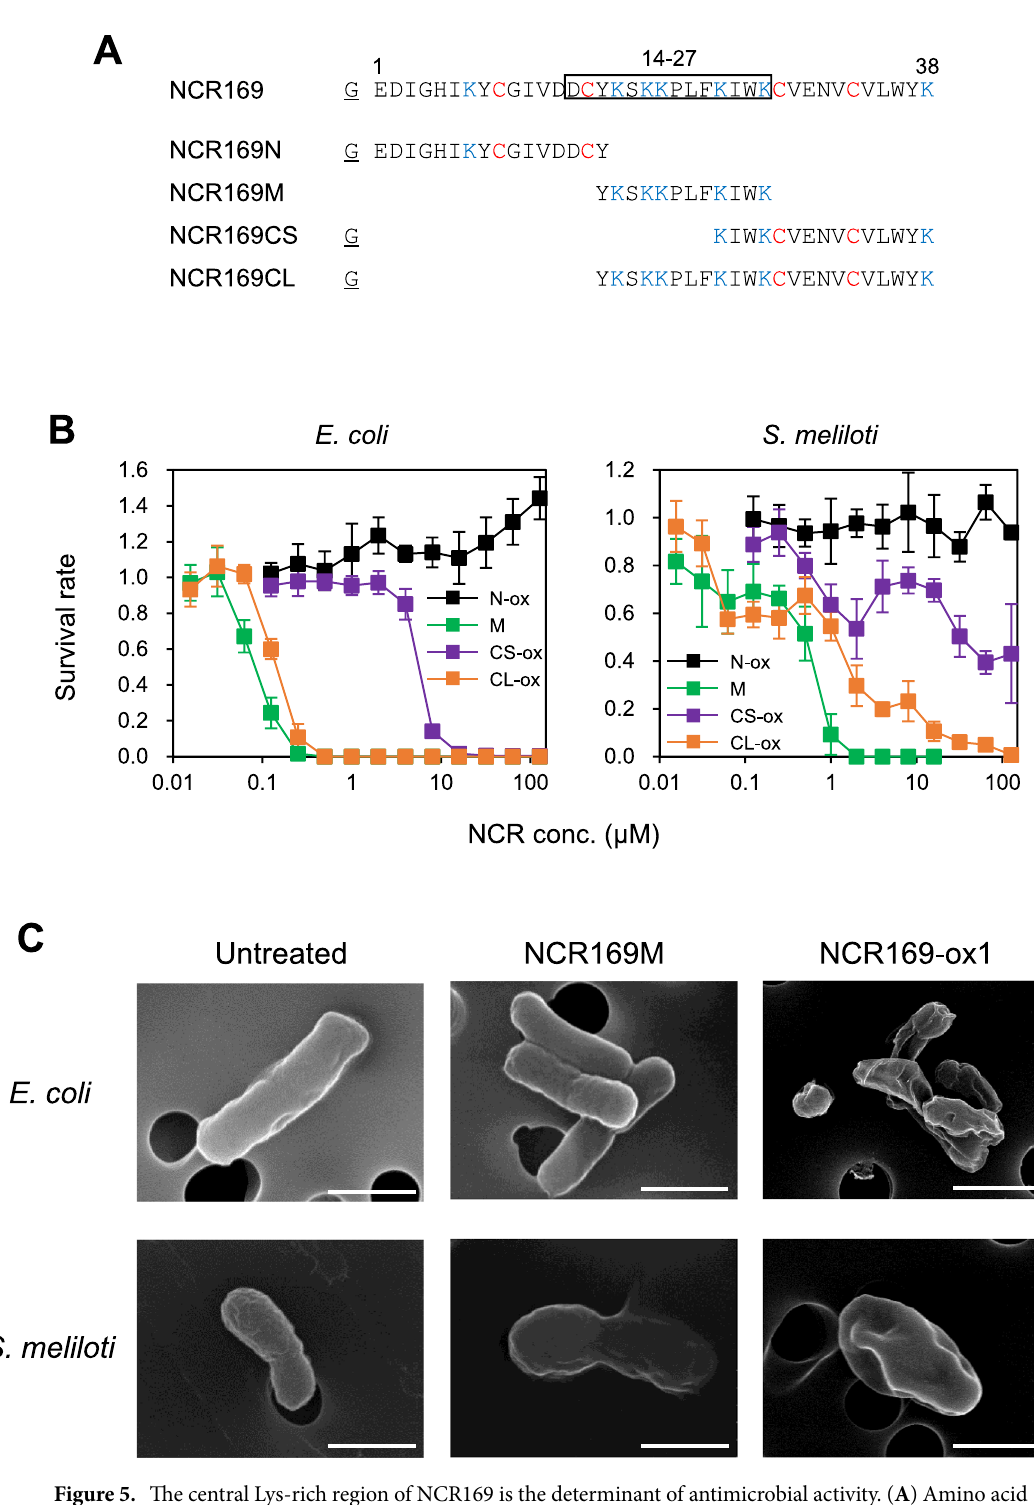
Figure 5. The central Lys-rich region of NCR169 is the determinant of antimicrobial activity. ( A ) Amino acid sequences of NCR169 and NCR169-derived peptides (NCR169N, NCR169M, NCR169CS, and NCR169CL) in this study. The boxed range (positions 14 to 27) indicates the predicted antimicrobial region. Lysine and cysteine residues are shown in blue and red, respectively. The first N-terminal residue, G (underlined), is the extra residue remaining after tag cleavage. ( B ) Antimicrobial activities of NCR169-derived peptides (NCR169N-ox, NCR169M, NCR169CS-ox, and NCR169CL-ox). Bacteria ( E. coli K-12 and S. meliloti ) were treated with various peptide concentrations, and survival rates were calculated based on untreated bacteria. All experiments were repeated at least four times. Error bars represent standard deviation (SD). ( C ) Scanning electron microscopy (SEM) images of E. coli and S. meliloti cells untreated or treated with NCR169. All treatments were performed at IC 100 for 24 h. (Scale bars: 1